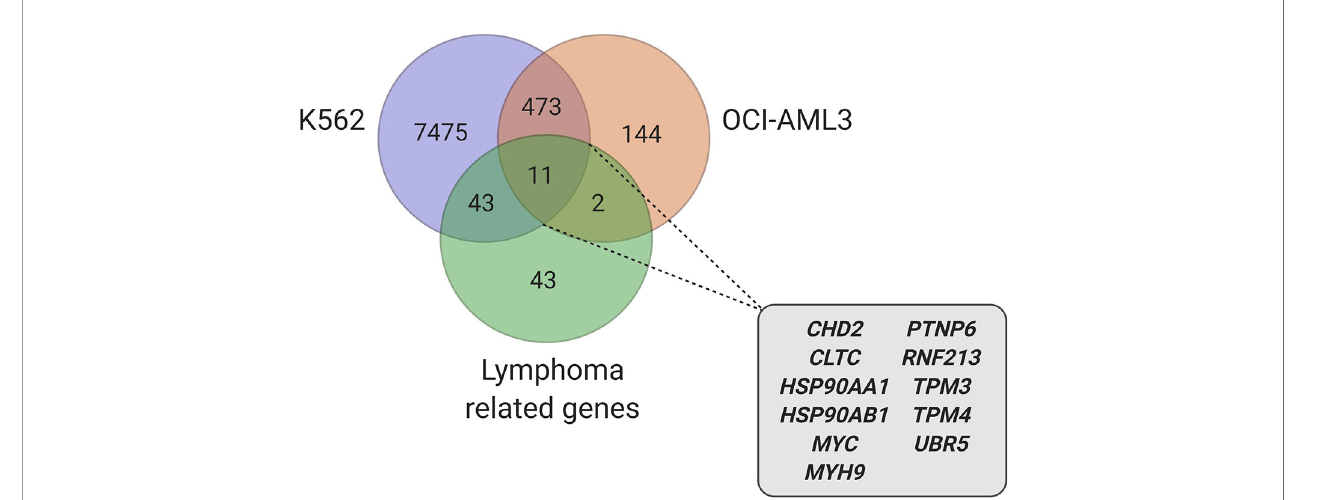
FIGURE 2 | Candidate genes, involved in lymphoma, identi fi ed in hnRNP K RIP-Seq datasets (39, 64) (created with